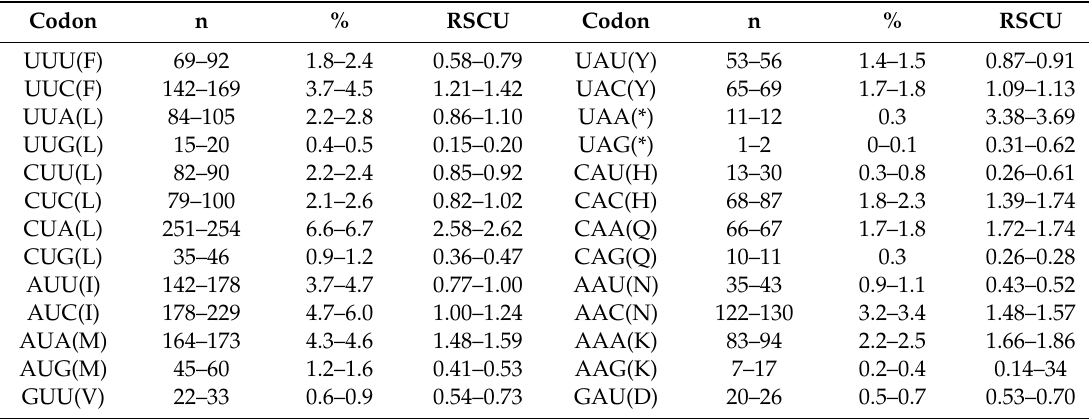
Codon usage of mitochondrial genomes protein-coding genes (PCG) of the three Microtus